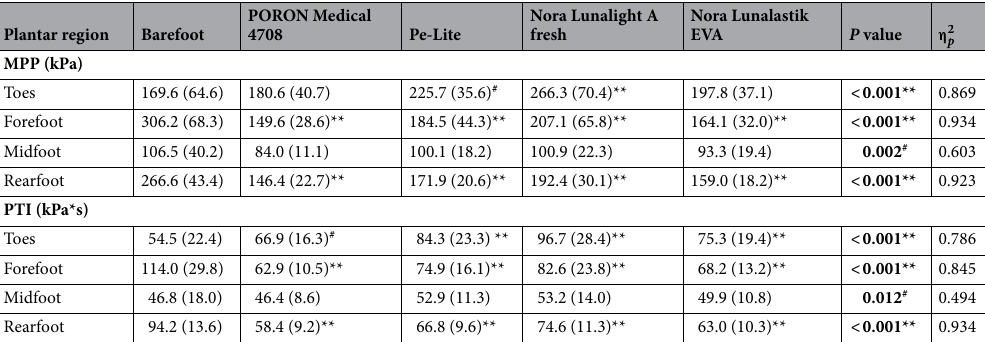
Table 2. Statistical results of MPP and PTI with and without insoles (mean (SD)). # Indicates P < 0.05, **indicate P < 0.001, significant difference from barefoot. MPP indicates mean of peak pressure. PTI indicates pressure–time integral. Significant values are in bold.